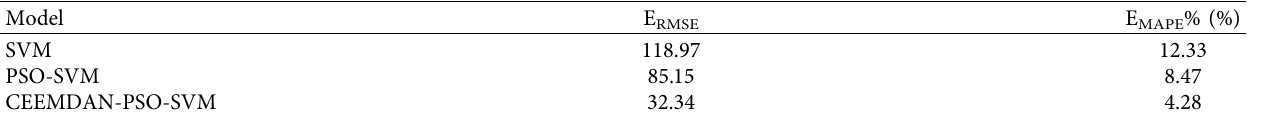
Figure 6: Comparison between forecasted value and actual value of each model. (a) SVM model. (b) PSO-SVM model. (c) CEEMDAN- PSO-SVM model. Table 1: Error comparison and analysis of each